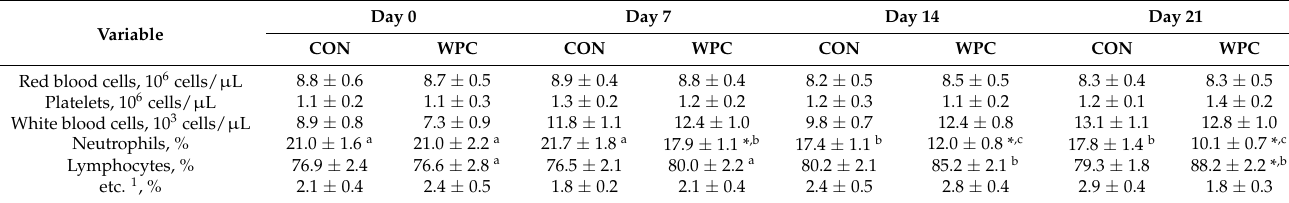
Table 2. Hematology parameters of rats fed experimental diets after antigen injection. Day 0 Day 7 Day 14 Day 21 Variable CON WPC CON WPC CON WPC CON WPC Red blood cells, 10 6 cells/ µ